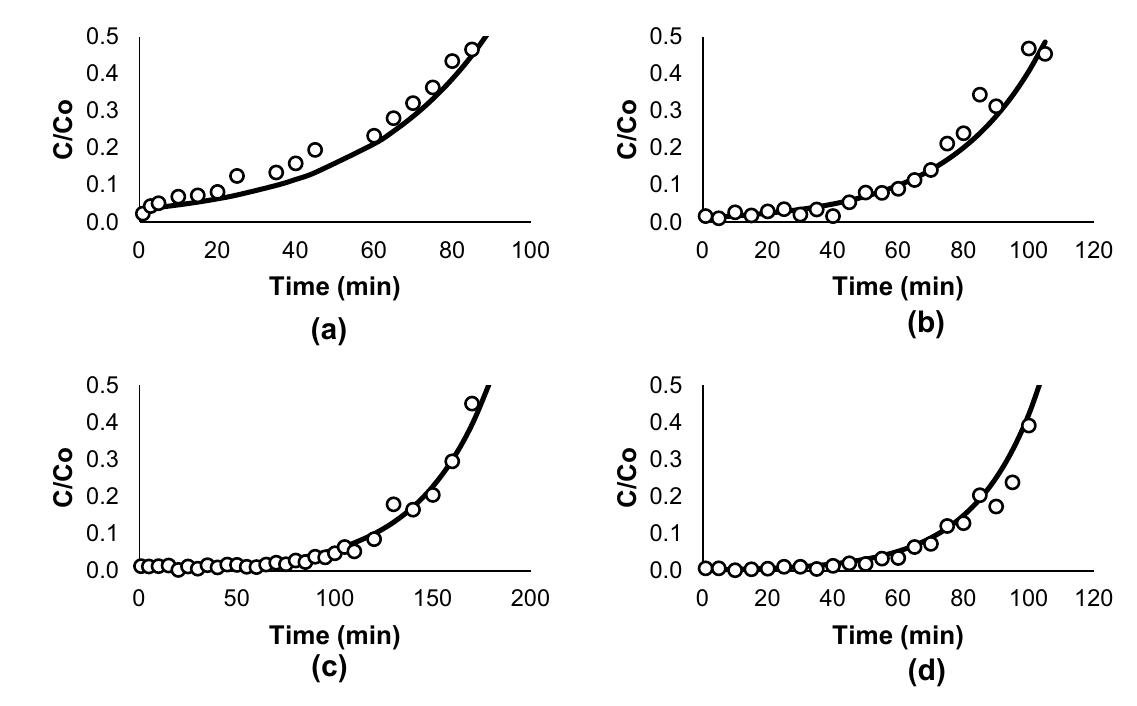
Fig. 4 Breakthrough curves of Cr (VI) and Ni (II) on natural sugar cane bagasse experimental (o) and simulates ( - ) at different experimental conditions: a Co (Cr) = 10 mg/L and m = 1.5 g; b Co